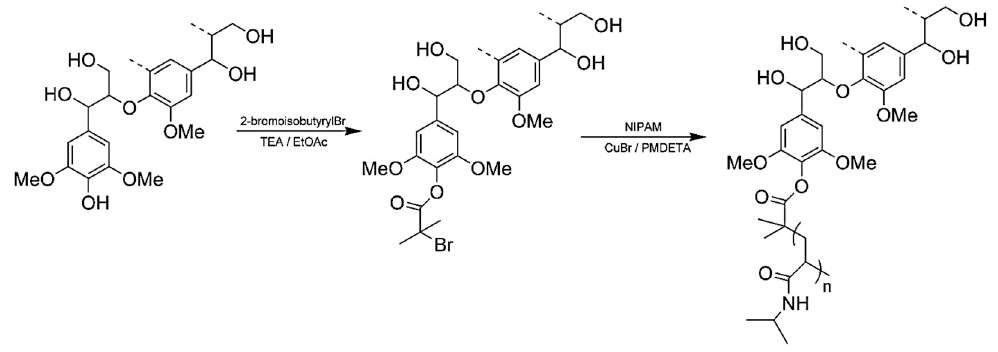
Figure 20. Preparation of lignin– g –polyNIPAM copolymers. Reproduced with permission [72].